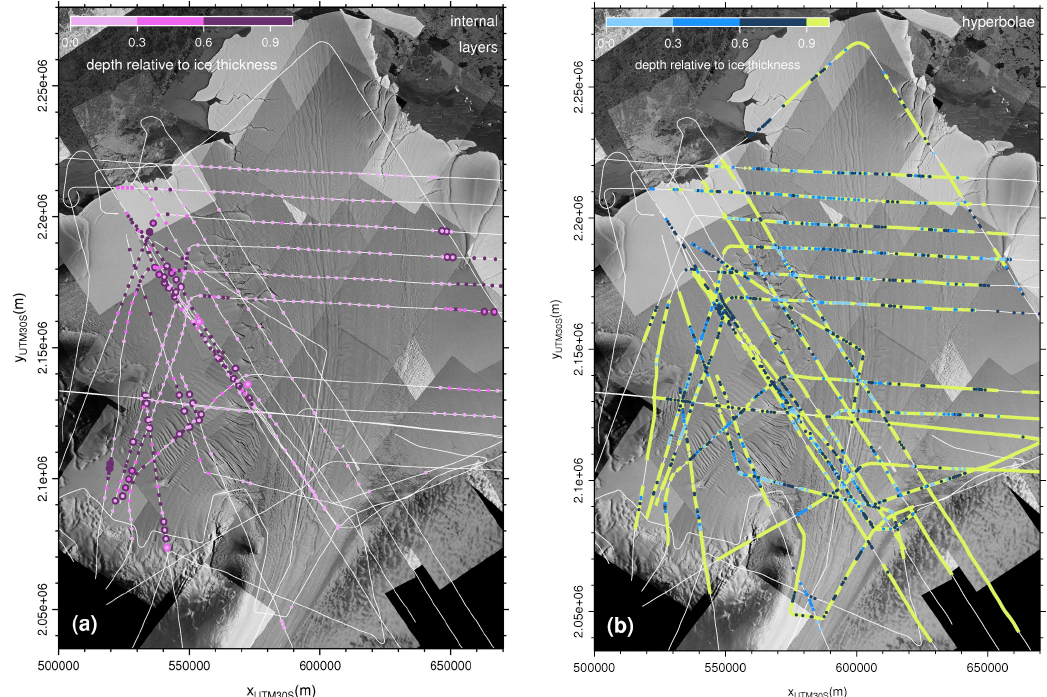
Fig. 4. First two of four maps displaying the RES classification of the internal structure superimposed on the TerraSAR-X mosaic. (a) Internal layers: light purple and medium purple denotes layers down to 30%, respectively 60% of the ice thickness, dark purple full layering. Large dots beneath the small dots are marking a second block of internal layers. (b) Hyperbolae: light blue denotes hyperbolae located at the top, yellowish at the bottom, blue in the interior of the ice shelf and dark blue denotes hyperbolae at top and interior locations.